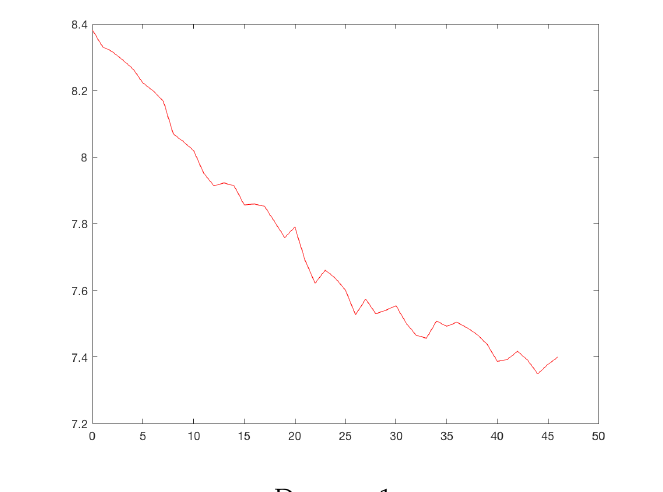
Figure 4. Bogota’s rises. Horizontal axis, days; vertical axis, logarithm of daily cases.